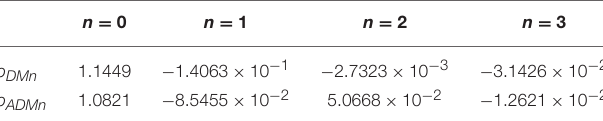
TABLE 2 | Table of coefficients in (23) and (24), where n refers to the coefficient number. n = 0